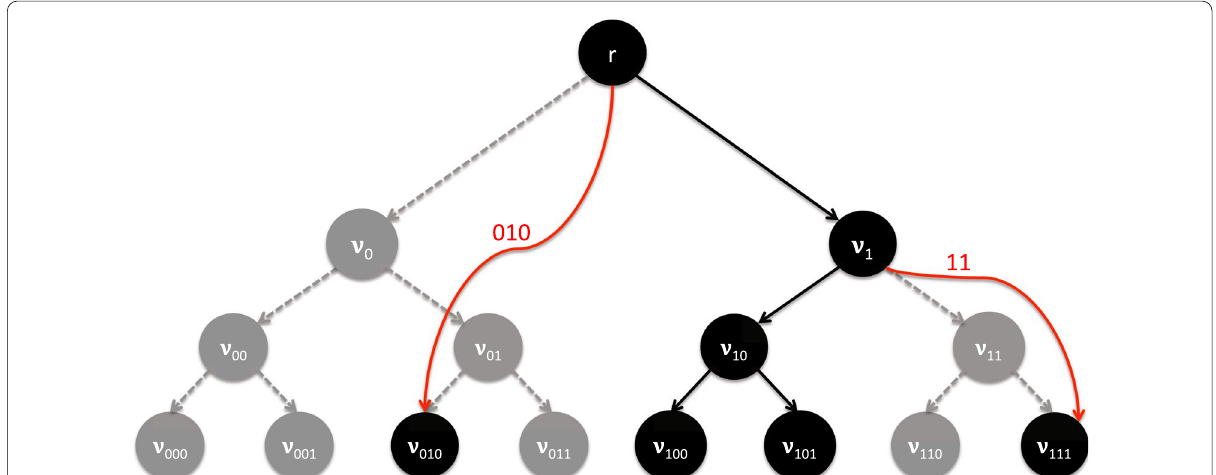
Fig. 5 Merkle-Patricia Trie. All unlabelled edges are assumed to have the label ‘0’ if they lean to the left and ‘1’ if they lean to the